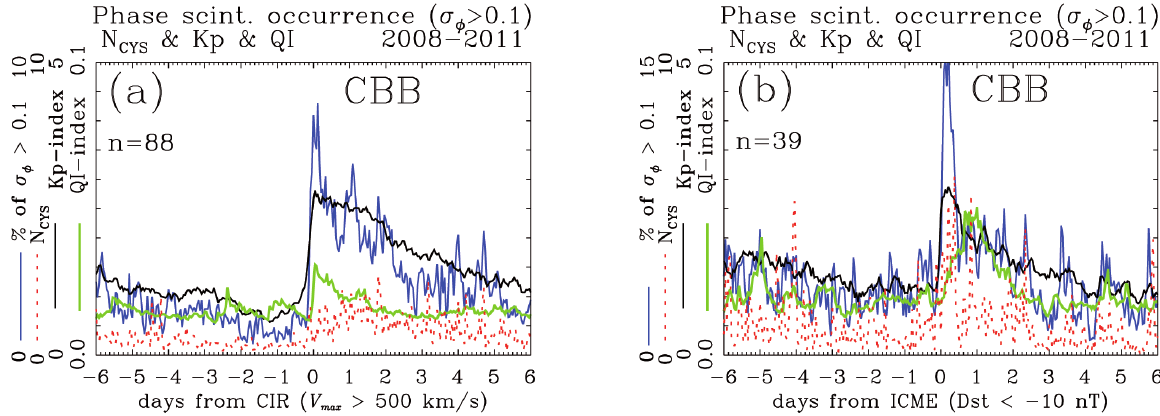
and phase scintillation occurrence. The time series are keyed by cys